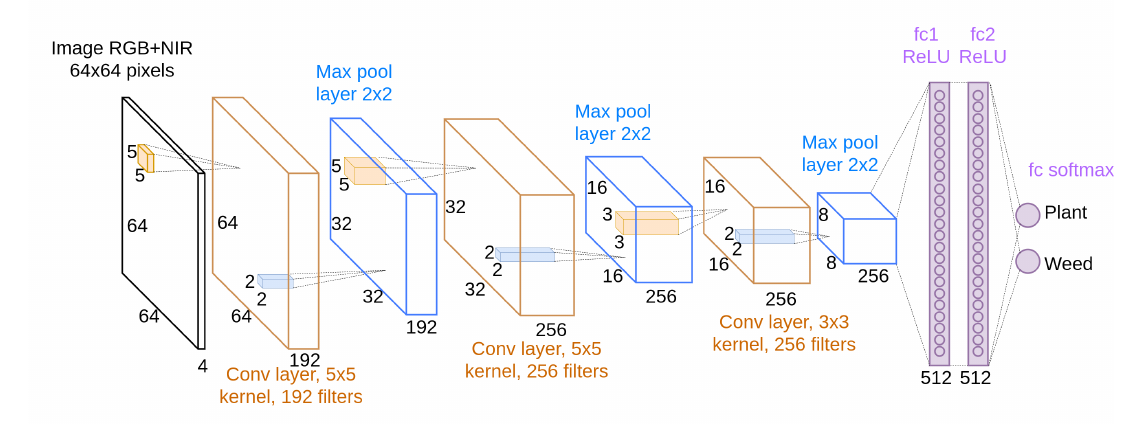
Figure 4. Detailed architecture used for the blob-wise classification.